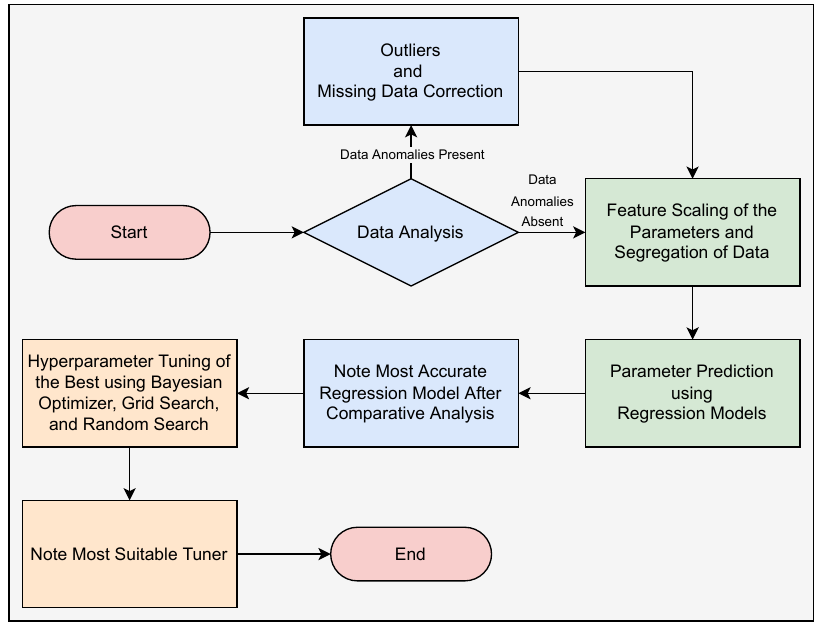
Figure 2. Proposed methodology for short term load